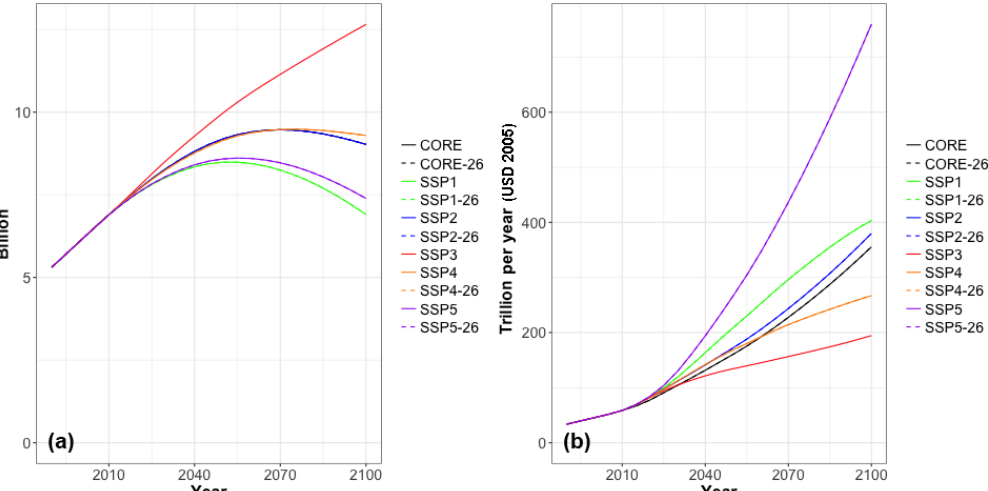
Figure 12. Global population and GDP for all scenarios. The CORE scenario is virtually identical to SSP2, but does differ with respect to near-term GDP. Note that GCAM v5.1 does not model the effects of climate policy on either GDP or population.